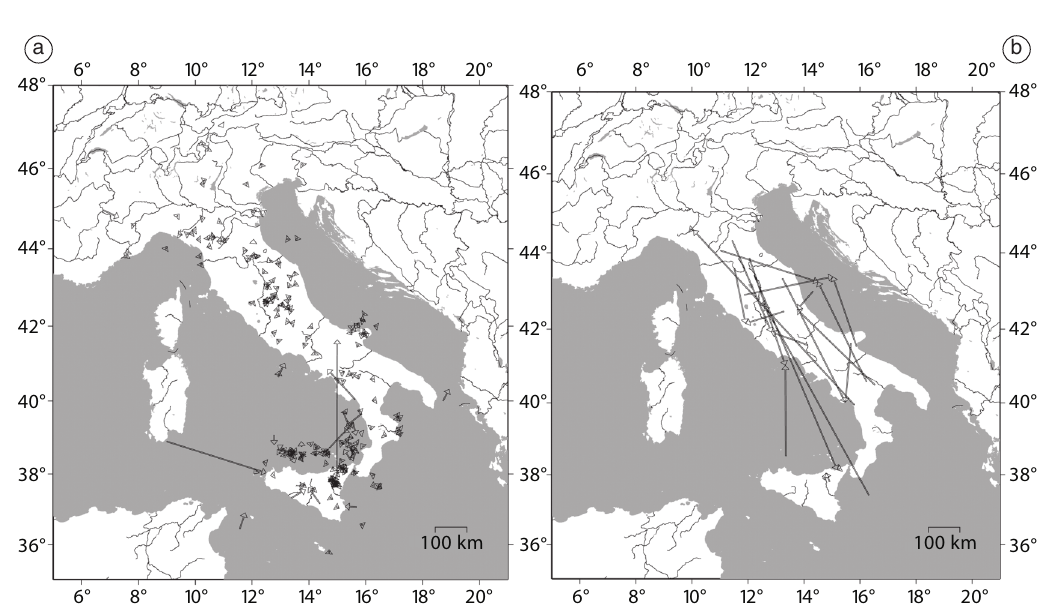
Fig. 6a,b. a) Left: mislocation vectors between final automatic and revised locations for earthquakes with ML ≥ 2.8 occurred in 2006. The arrows point to the revised solution. b) simultaneous couples of events erroneously lo- cated in real time as single earthquakes during 2006. The arrows point to the mislocated epicenters, the lines end in the two correct